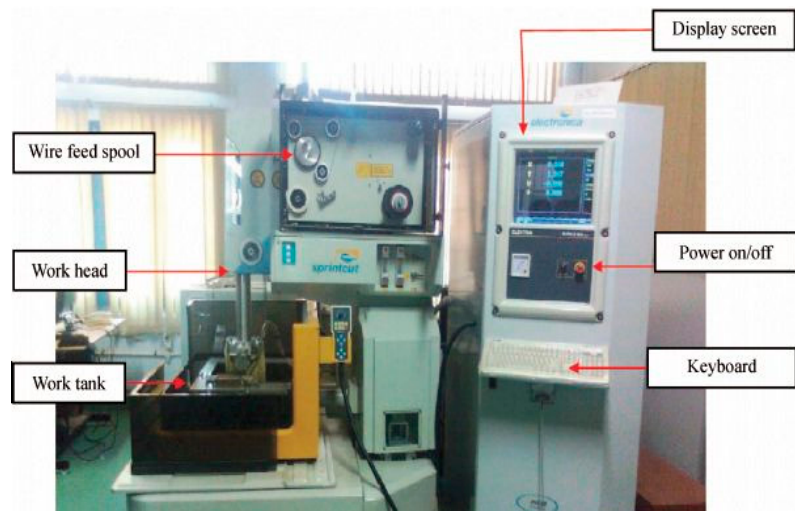
Figure 2. WEDM (SPRINTCUT-734).